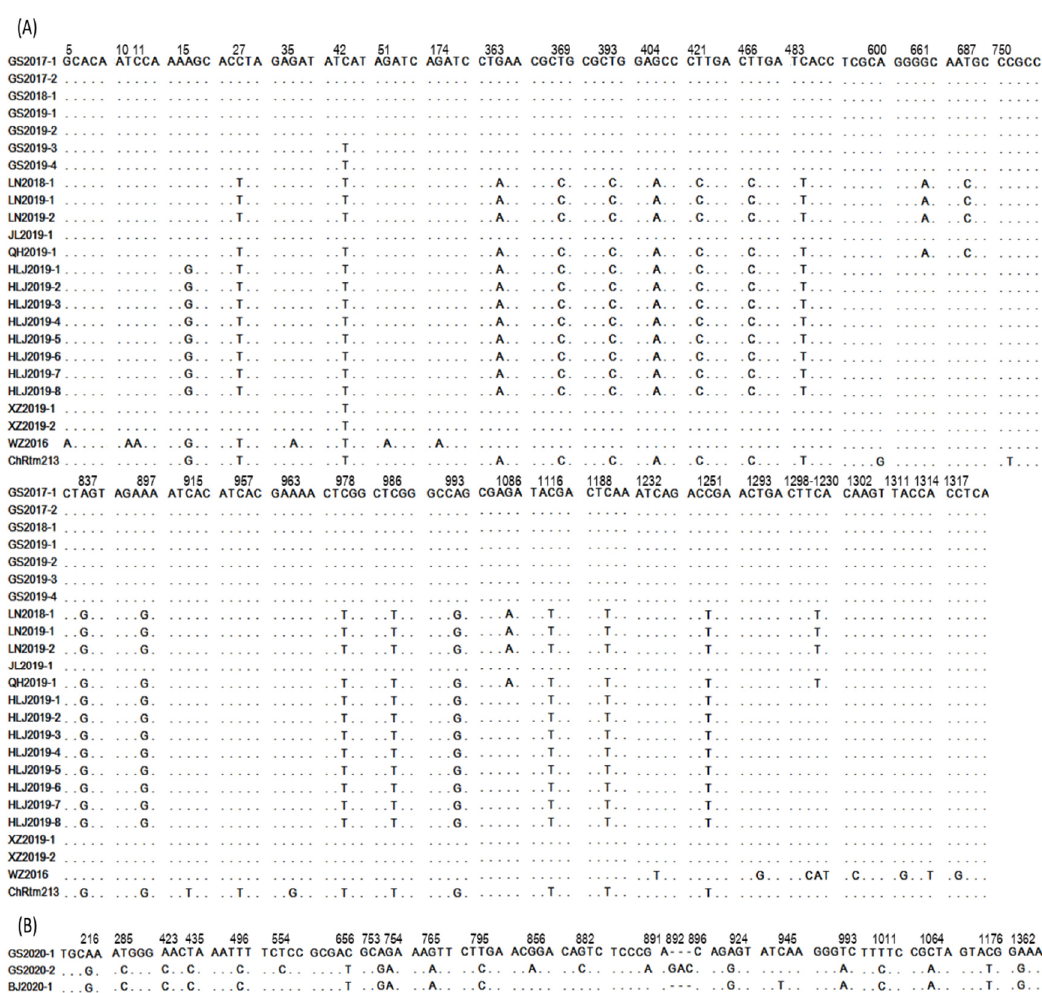
Figure 2. Distribution of polymorphic sites on the VP2 gene coding region sequences (CDS) of Chinese IPNV isolates collected from different farms during 2013 through 2020. ( A ) Chinese genogroup I IPNV isolates. GS2017-1 isolate was used as a reference strain here. ( B ) Chinese genogroup V IPNV isolates. GS2020-1 isolate was used as a reference strain here. The numbers above nucleotides represent the position that polymorphic sites were located, and all of the polymorphic sites were indicated by representing the corresponding nucleotides that differ from the reference isolates.